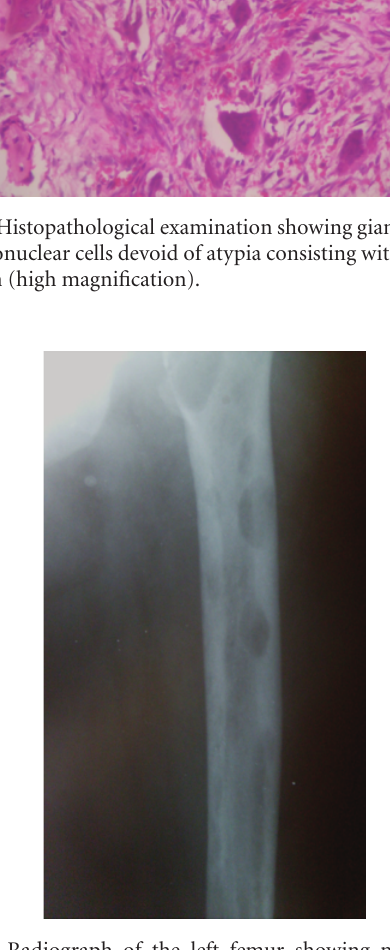
Figure 4: Radiograph of the left femur showing multiple lytic